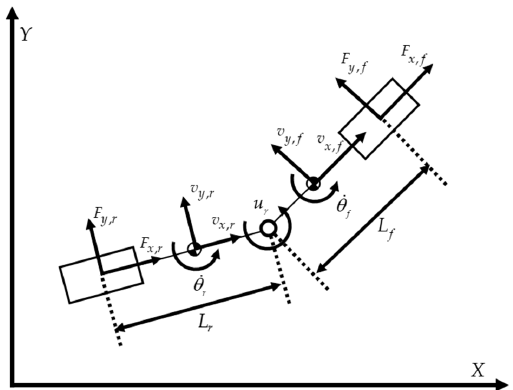
Figure 5. Free body diagram of the AAEV.